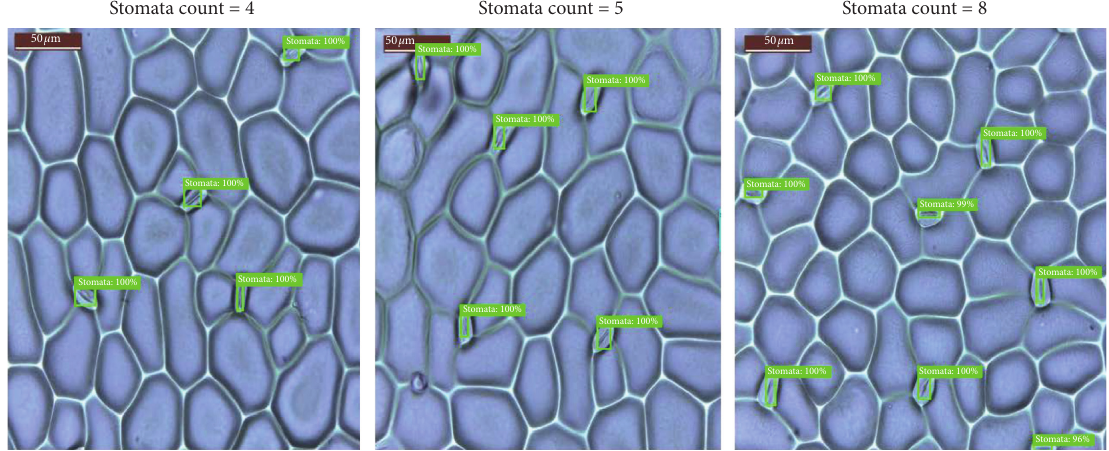
Figure 6: Stomata detection and counting.